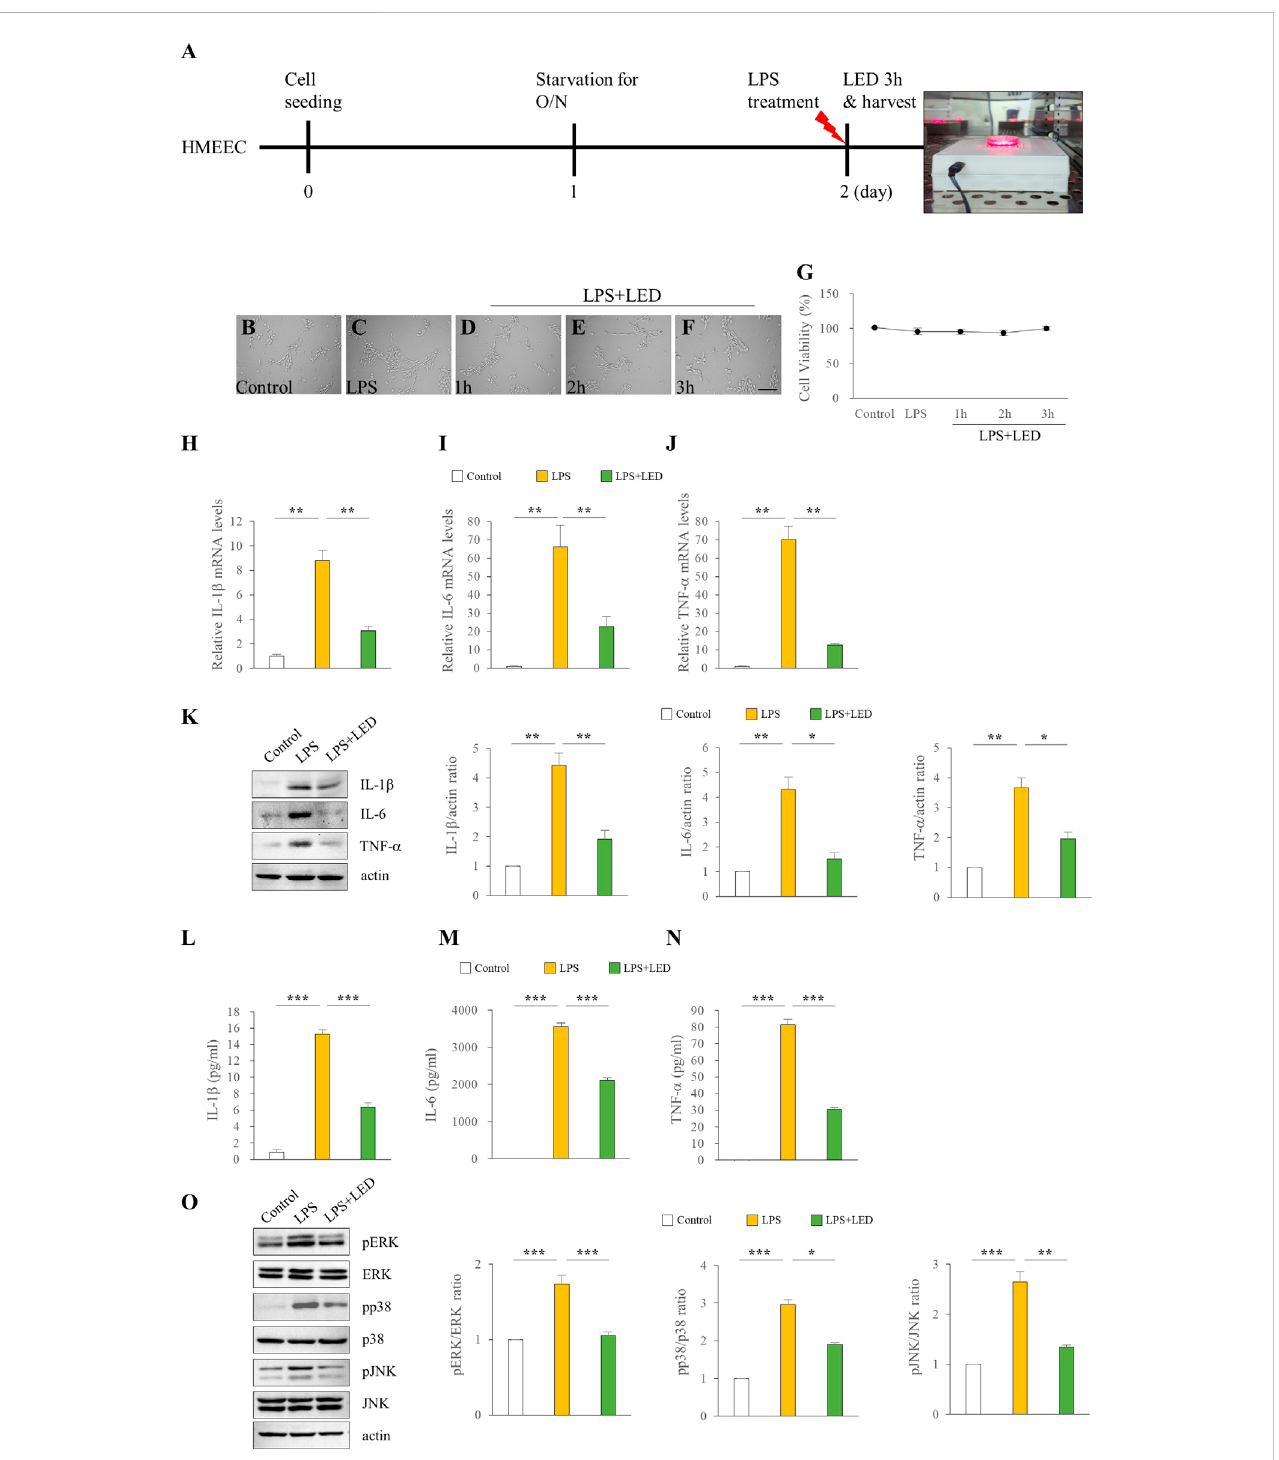
FIGURE 4 Reduction oftheexpressionofpro-in fl ammatorycytokinesinHMEECs byLEDirradiation. TreatmentofHMEECswithLPS(50 μ g/mlor10 μ g/ml)for3 h (A) .Cellmorphology (B – F) andviability (G) ofHMEECsfollowingLEDirradiation.Thescalebarrepresents200 µm (B – F) .qPCRassayofthemRNAlevelsofIL- 1 β (H) , IL-6 (I) , and TNF- α (J) in HMEECs. Data are presented as the relative fold (n = 6). Kruskal Wallis test: ( p ) = 0.001. Western blotting of the protein expression levels of IL-1 β , IL-6, and TNF- β (n = 9) (K) . One-Way Anova: * p < 0.05, ** p < 0.01, and *** p < 0.001. ELISA of pro-in fl ammatory cytokines including IL-1 β (L) , IL-6 (M) , and TNF- α (N) in HMEECs (n = 3). Kruskal Wallis test: ( p ) = 0.001. Reduction of pro-in fl ammatory cytokines by LED irradiation through the blockade of MAPK signaling (n = 6) (O) . Kruskal Wallis test: ( p ) = 0.002 for pERK and ( p ) = 0.001 for pp38 and pJNK. Mann-Whitney U test: * p < 0.05, ** p < 0.01, and *** p < 0.001. Data are expressed as the mean ±